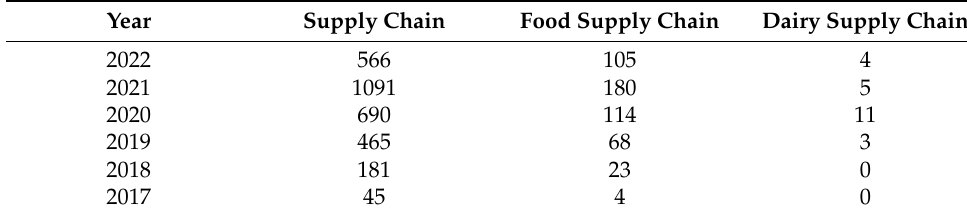
Table 2. Year specific publication analysis.